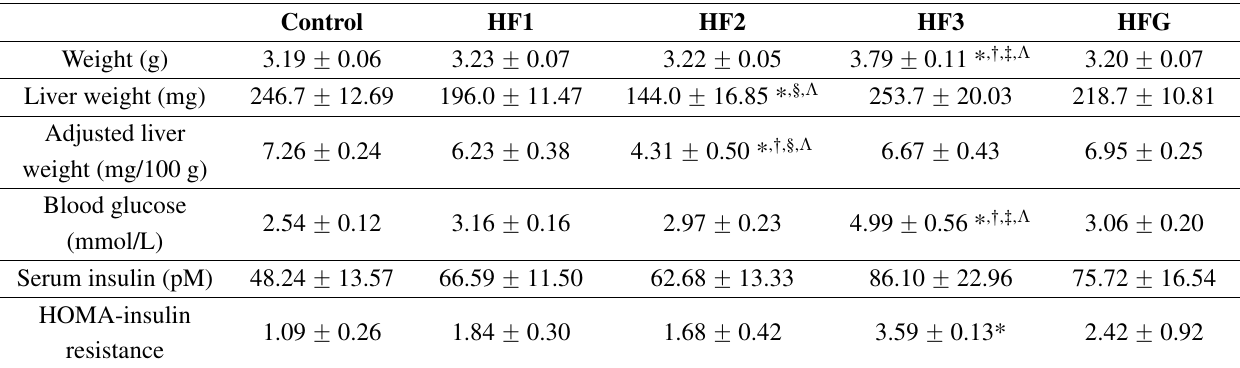
Table 1. Fetal anthropometry and metabolic parameters of 20-day-old rat fetuses. Control HF1